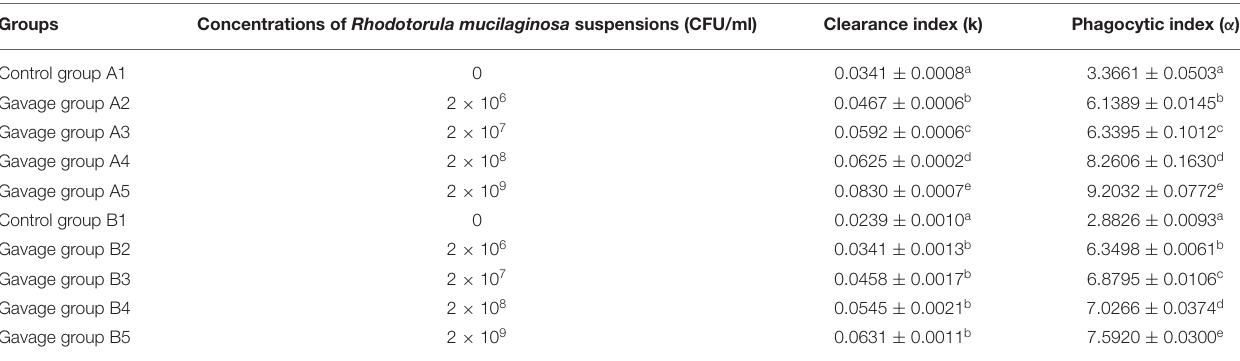
TABLE 3 | Effects of R. mucilaginosa on carbon clearance and phagocytic index in mice (15 days and 30 days). Groups